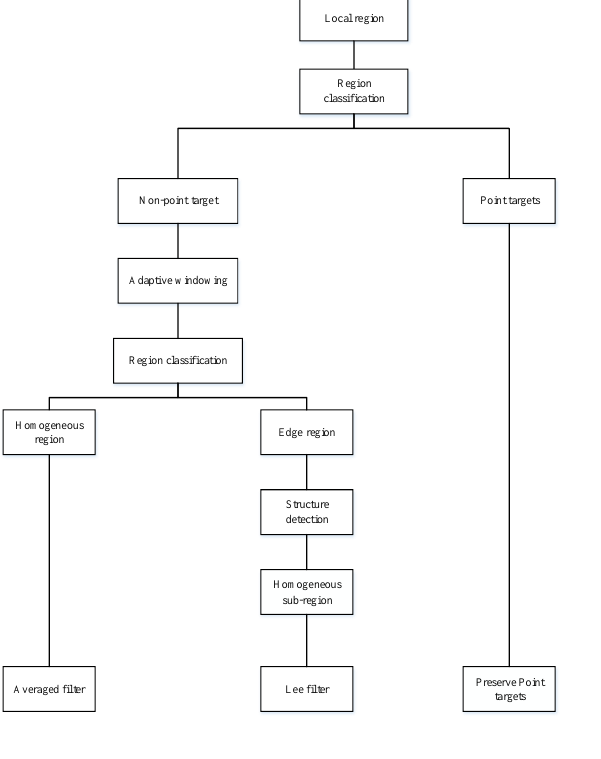
Fig 3. The flowchart of our method